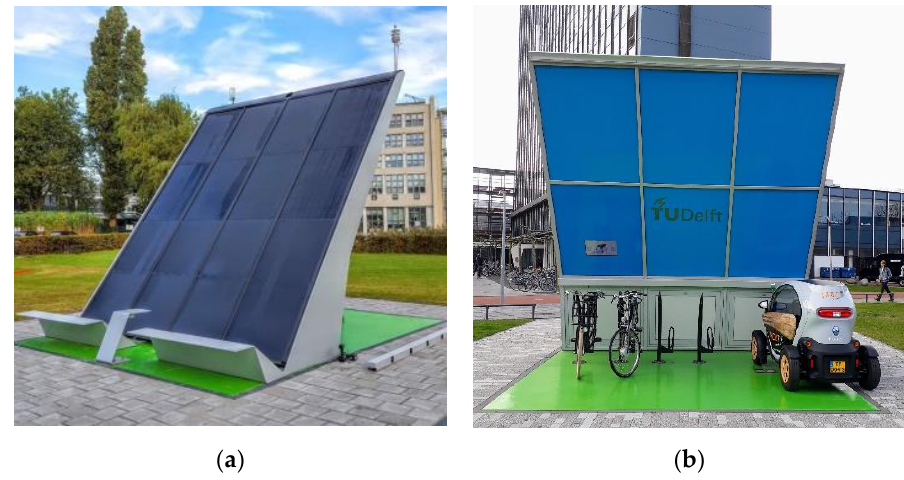
Figure 2. ( a ) Front view of solar e-bike charging station showing solar panels. ( b ) Back view showing the charging status display screen, the e-bikes, and Twizy EV charging.